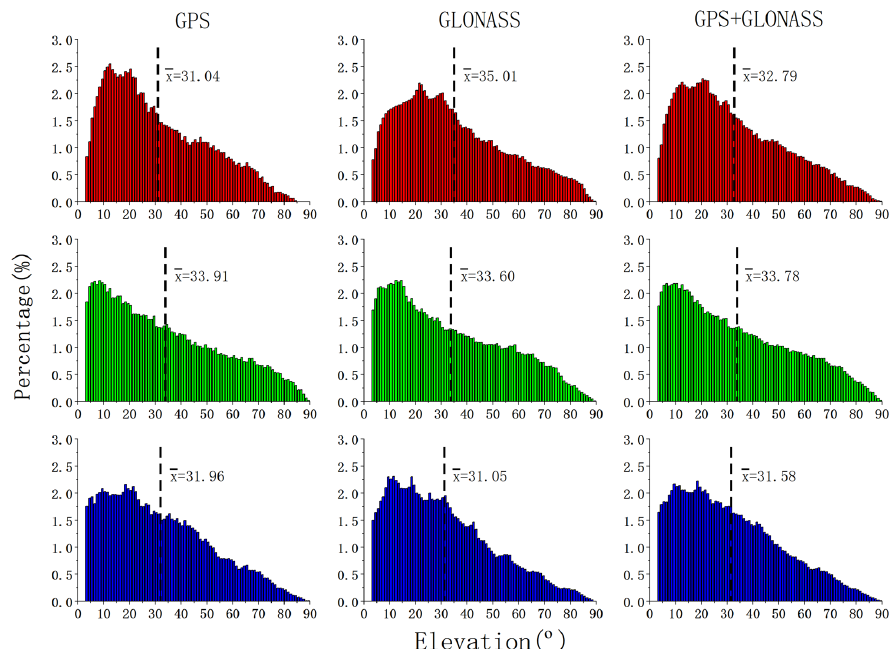
Figure 6. The histogram of elevation distribution of the high (red), middle (green), and low (blue) latitude networks, the position of the dashed line and the value x − indicate the mean elevation. Remote Sens. 2022 , 14 , x FOR PEER REVIEW From Figure 6, GLONASS has a much better elevation distribution than GPS in the high latitude network. The most observed GLONASS satellites’ elevation angles in the high latitude network are between 13–33 degrees, while those of GPS are between 6–26 degrees, which are obviously lower than that of GLONASS. In addition, the mean eleva- tion angle of GLONASS is 35.01°, which is 3.97 higher than that of GPS. In the middle latitude network, the elevation angle distribution and average elevation angle between GPS and GLONASS have inconspicuous disparity. In the low latitude network, the per- centage peak of GLONASS corresponds to an obviously lower elevation angle than GPS.